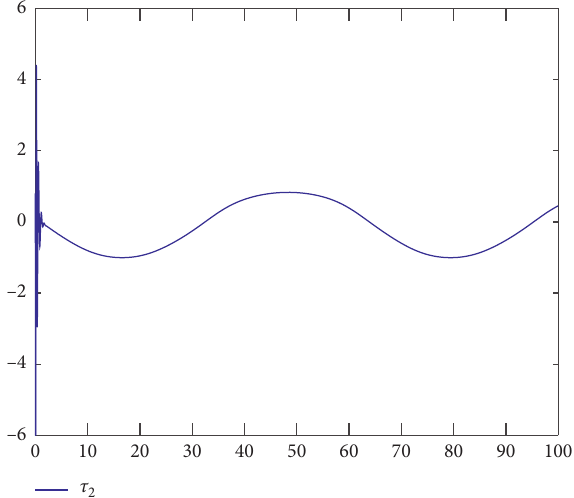
Figure 3: The response of the state variable τ